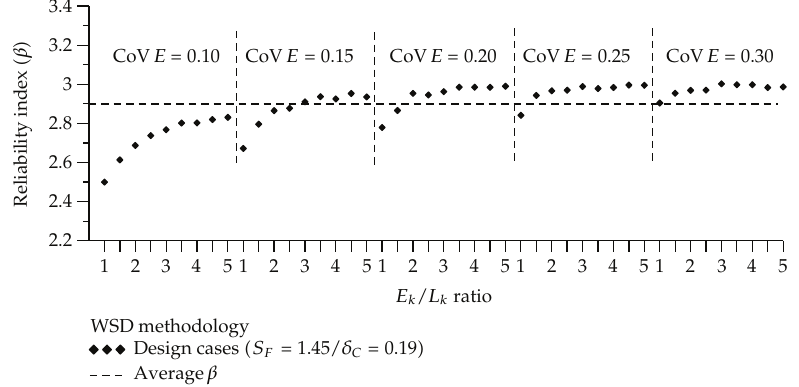
Figure 8: Reliability indexes of calibrated WSD designs considering δ C (cid:8) 0 . 19 (cid:3) experimental tests (cid:4)